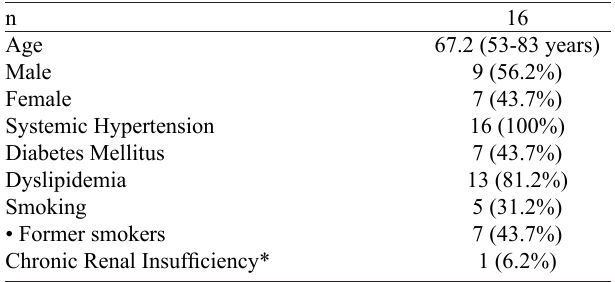
Table 1. Demographical Characteristics of the analyzed patients.